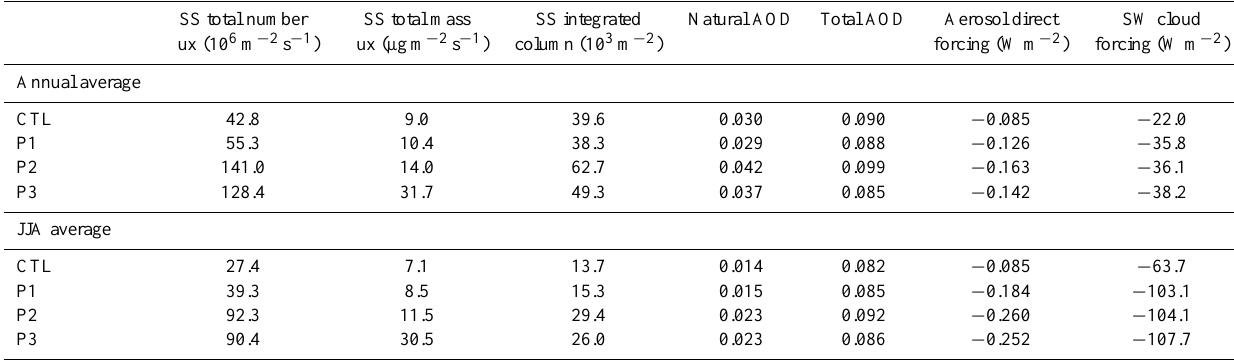
Table 3. CAM-Oslo results averaged between 70 and 90 ◦ N. The averaging includes all grid points (land and ocean) and covers the final five years of the model simulations.